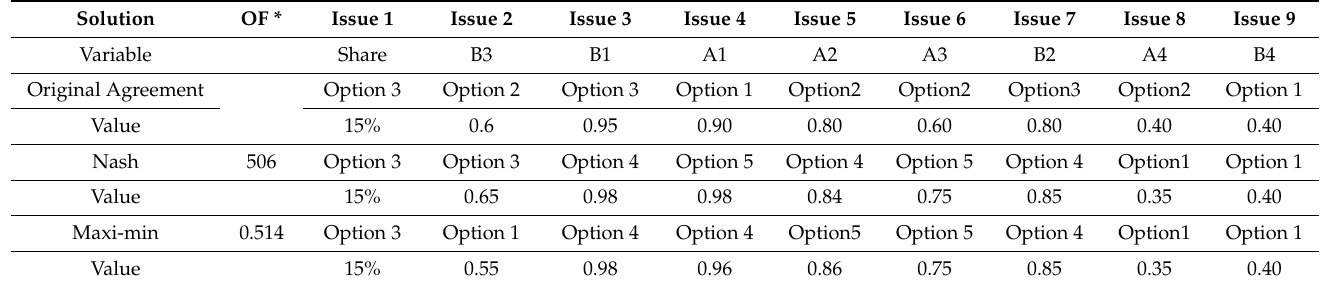
Table 11. Summary of the issues and options of the three contracts of the FP and SP.